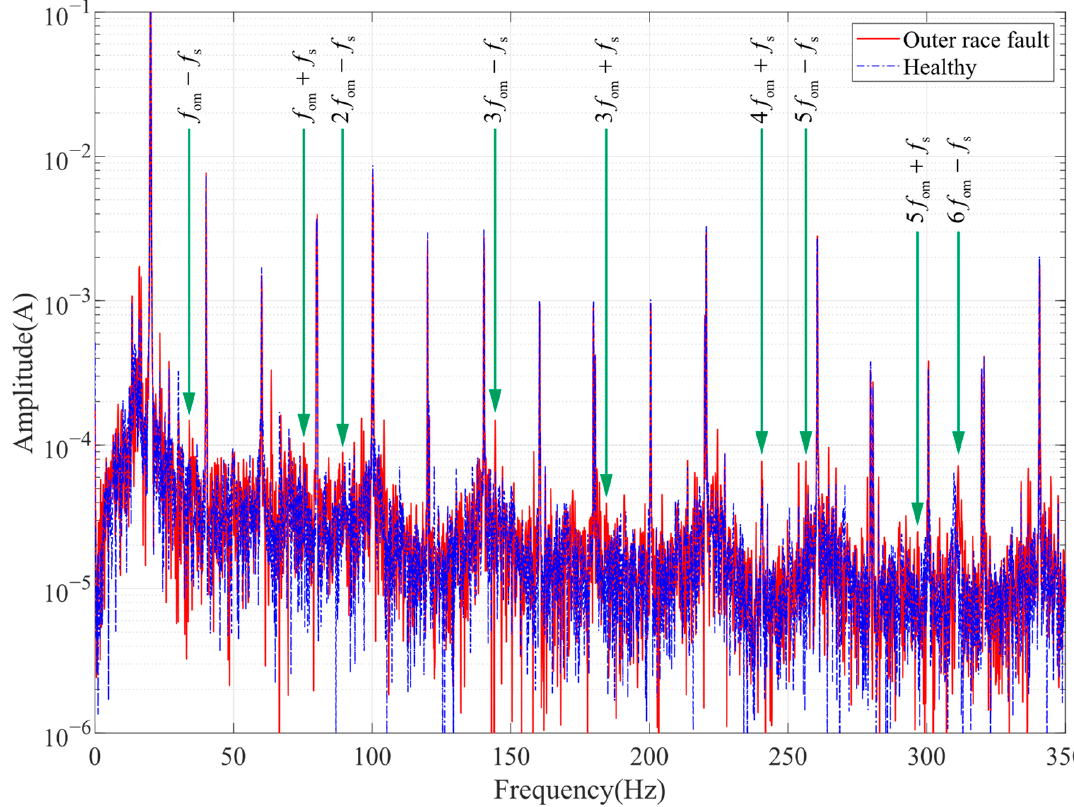
Figure 24. Comparison of stator current experimental signal spectrum under outer race fault (20 Hz).